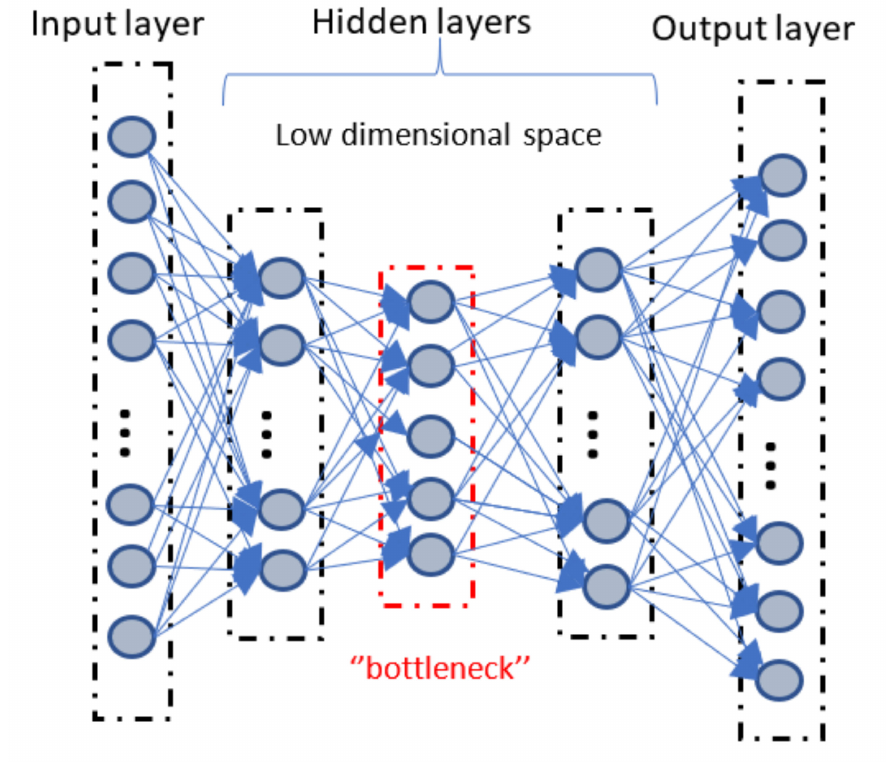
Figure 3. The schematic structure of a conventional auto-encode. The AE is trained by minimising the reconstruction error ( E , D ), i.e., the difference between the input data and their reconstructed output. In terms of weights and biases for neural networks, the AE can be represented by Equation